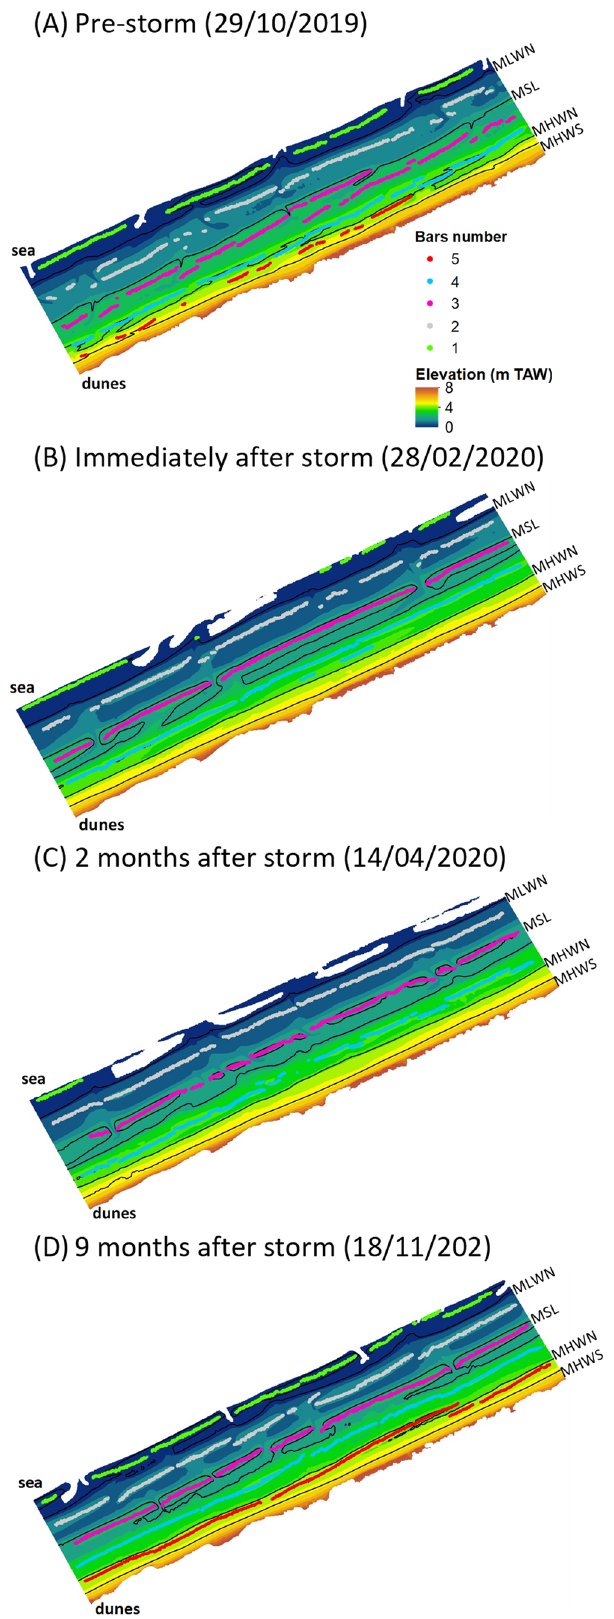
Figure 5. Maps of the automatically detected bars (thick coloured lines) superimposed on their respective DSMs at ( A ) pre-storm (29 October 2019), ( B ) immediately after storm (28 February 2020),